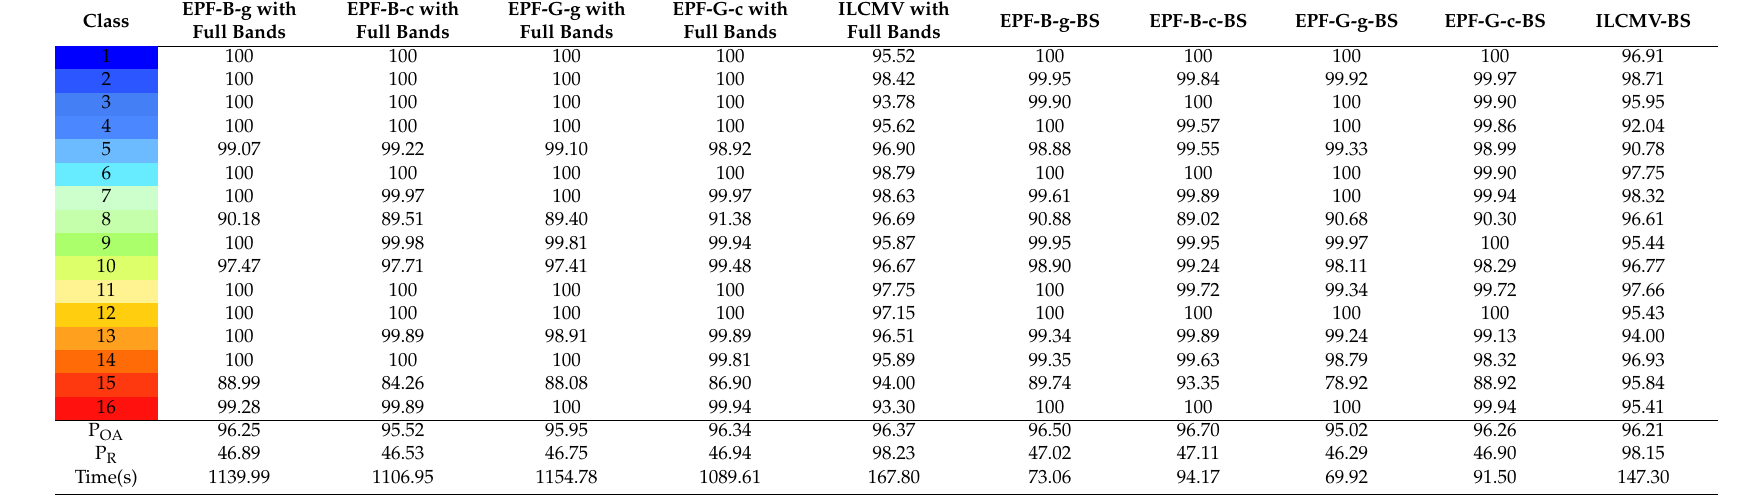
Table 12. P OA and P R calculated by the classification results using full bands and the bands selected by SC LCMV-BSS in Table 2 for